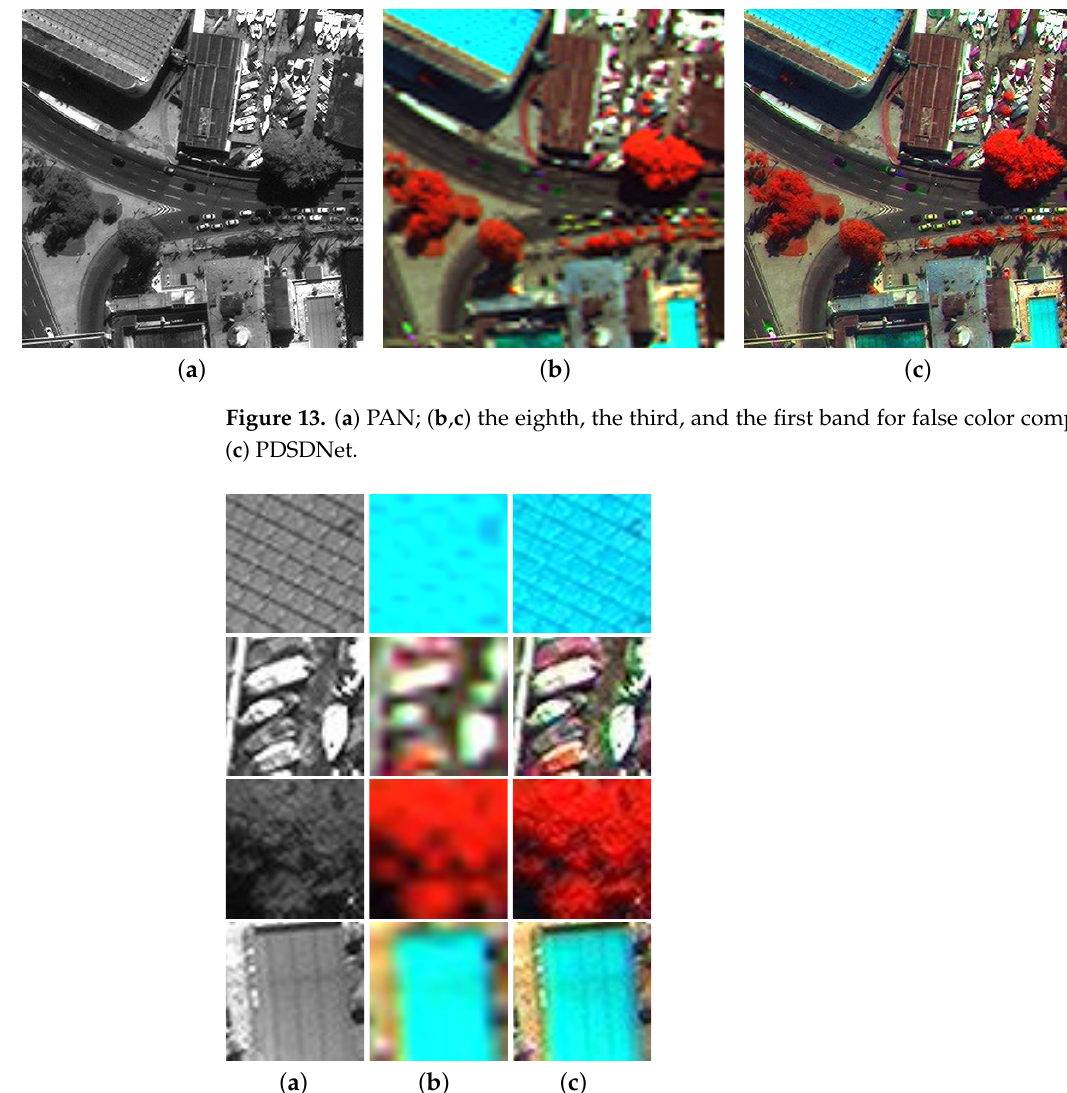
Figure 14. Local details: ( a ) PAN; ( b , c ) the eighth, the third, and the first band for false color composite; ( b ) MS; ( c )